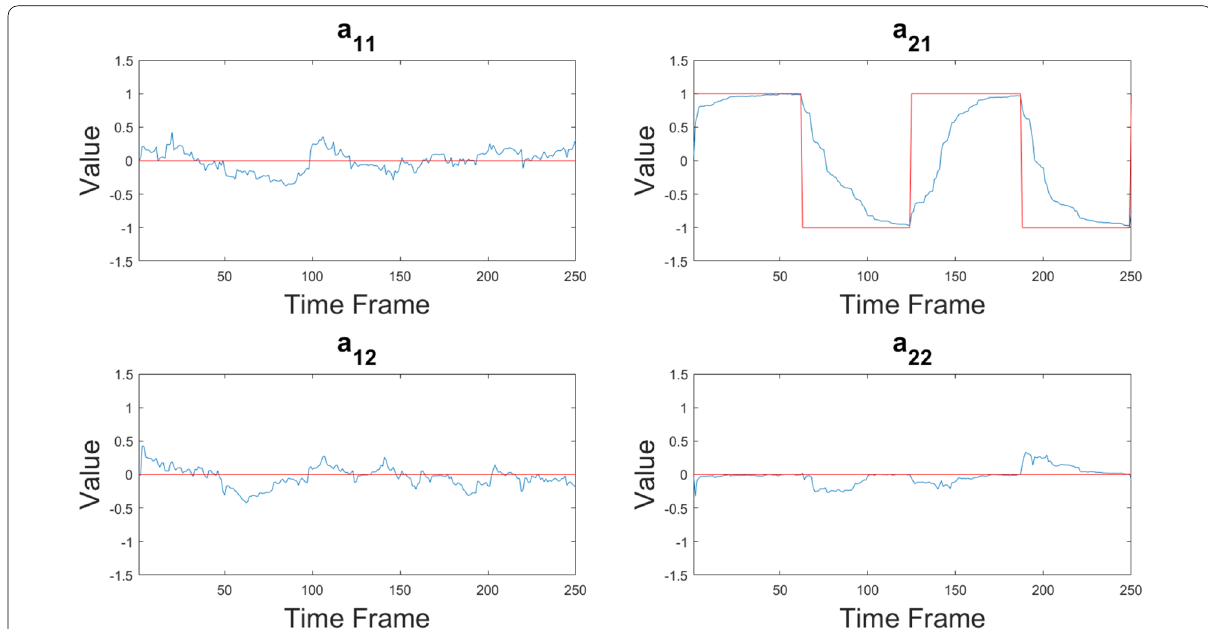
Fig. 4 Time courses of the hidden parameters a ij in the case of a 2-node network with non-stationary coefficient a 21 alternating between 1 and − 1 . Red lines represent the true values, while blue lines represent the estimates obtained by